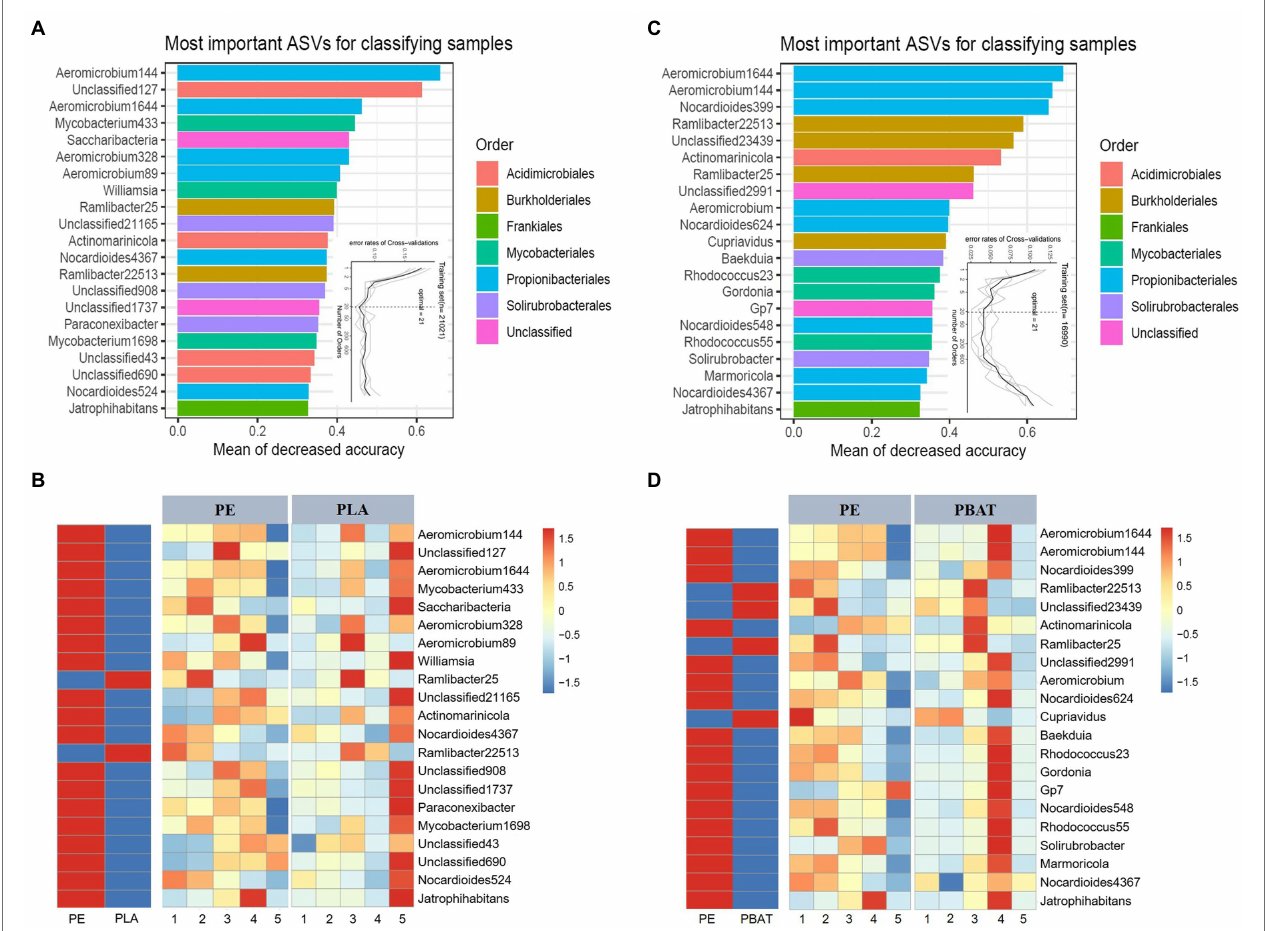
FIGURE 4 | Biomarkers of plastic-related microbiota between PLA/PBAT and PE. The top 21 biomarker bacterial ASVs are accurately identified by Random-forest model in PE/PLA (A) and PE/PBAT (B) . The biomarkers are ranked in descending order of importance to the accuracy of the model. The inset represents 10-fold cross-validation error as a function of the number of input ASVs used to differentiate PE and PLA/PBAT microbiota ranked by variable importance. The corresponding heatmaps show the relative abundances of the top 21 biomarkers over 5 months for the plastics (C,D)